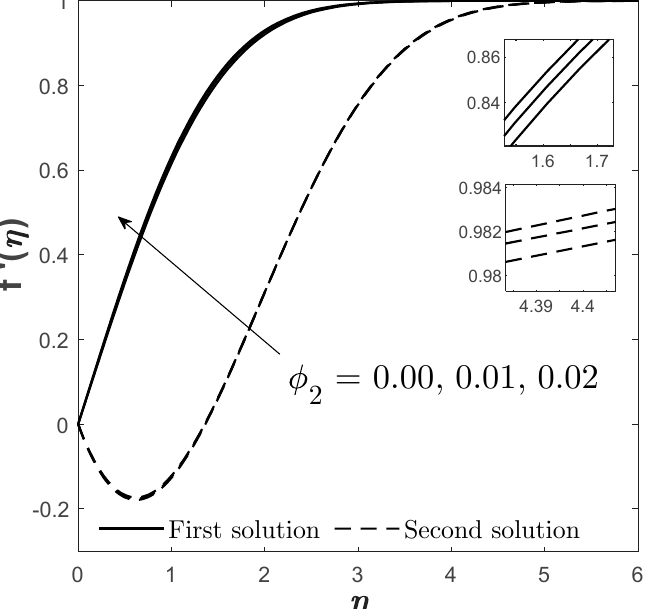
(cid:48) ( η ) for varied φ = Rd = Sc = Sr = 1, λ = − 1, Du = 0.03, and 2 when N